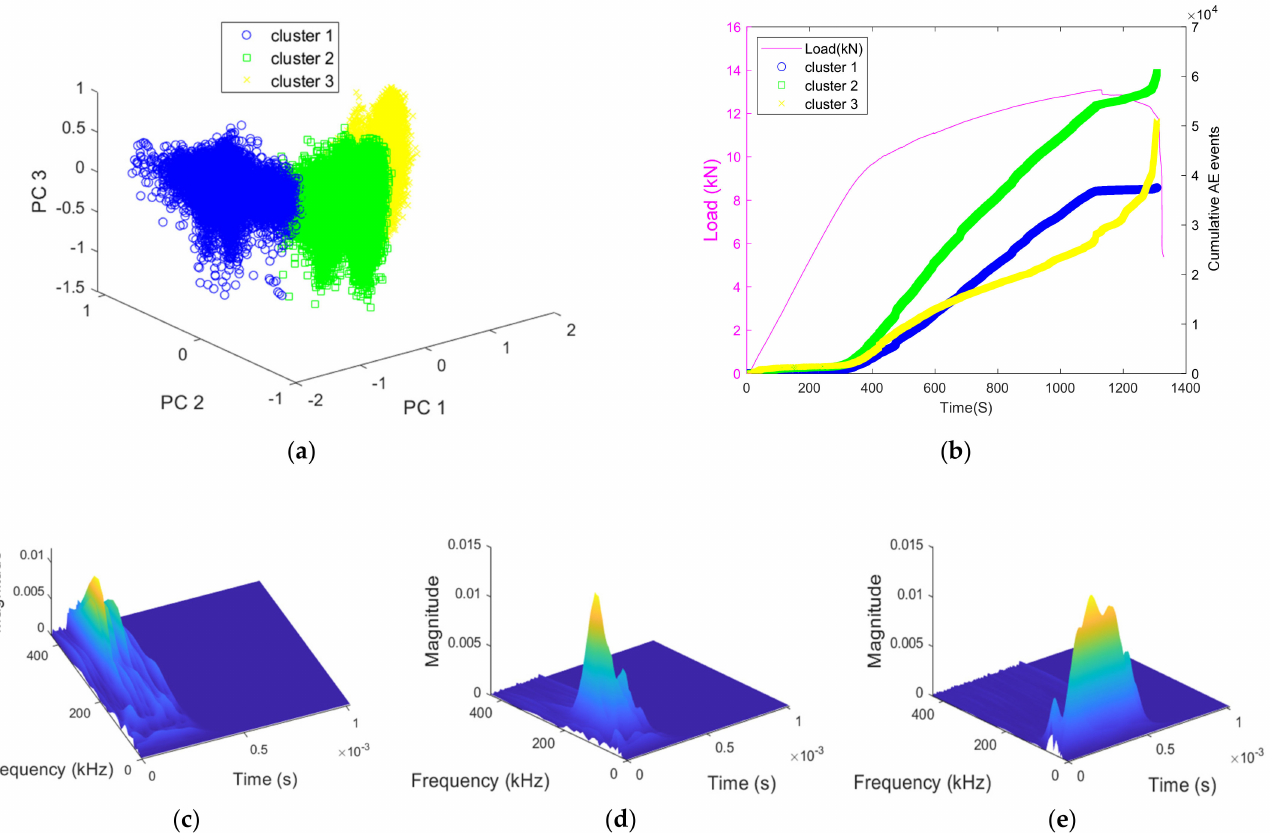
Figure 16. Clustering using k-means and significance of the obtained clusters (shown for AE data of sample 2): ( a ) obtained clusters, ( b ) variation in cumulative hits of the clusters; a typical wavelet transformed signal of ( c ) cluster 1, ( d ) cluster 2, and ( e ) cluster